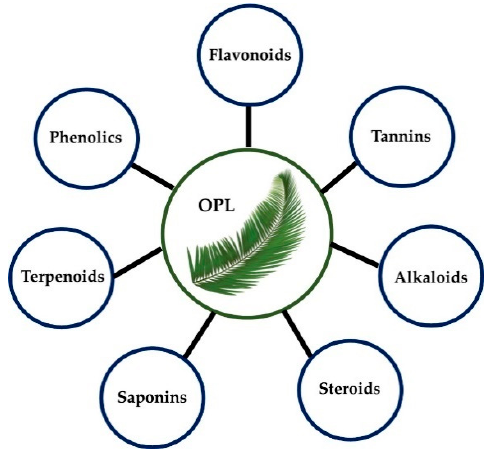
Figure 1. Groups of compounds present in oil palm leaves (OPLs).